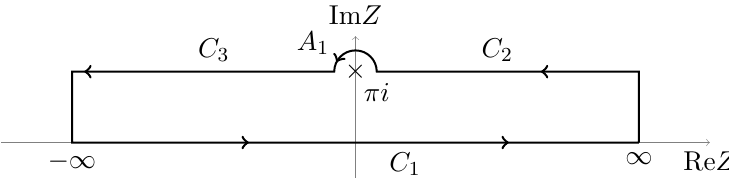
Figure 1 . A contour for the evaluation of (3.34). There is a simple pole at Z = πi inside the